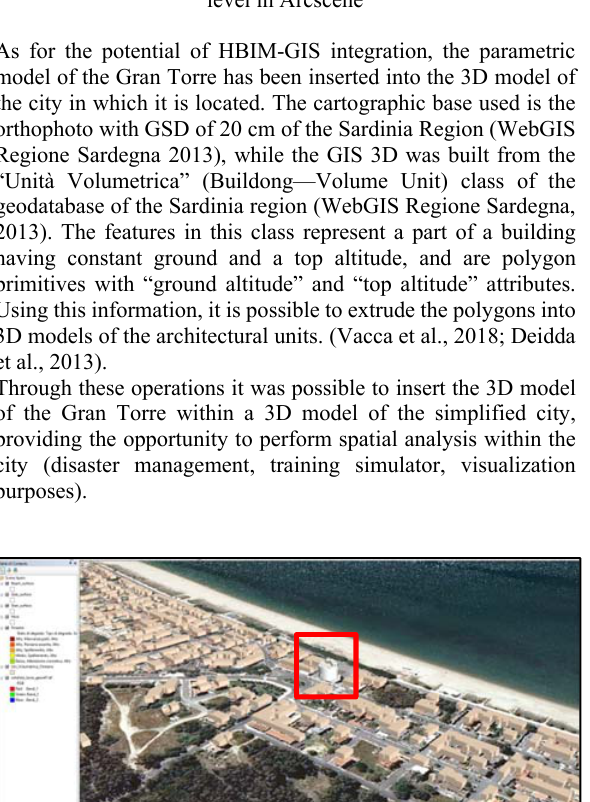
Figure 9. Selection of the windows with high transformability level in Arcscene